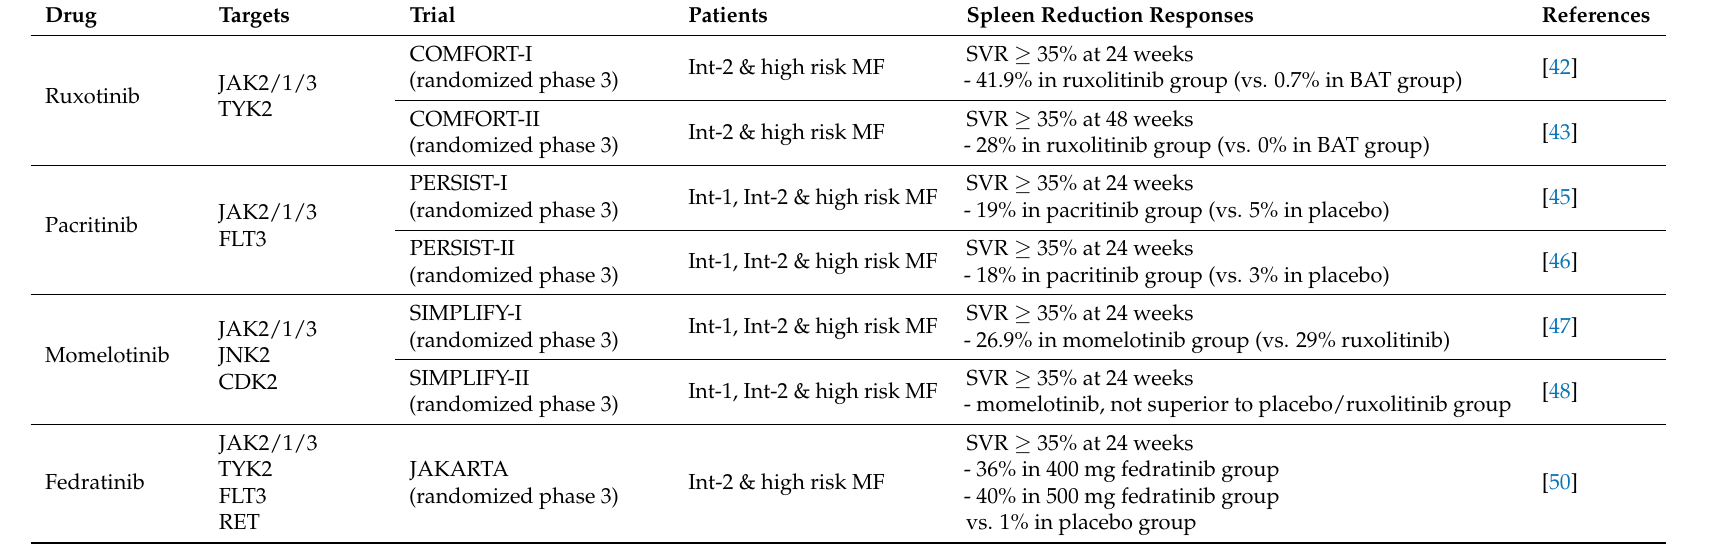
Table 2. Janus kinase (JAK) inhibitors, as efficacious agents for splenomegaly in